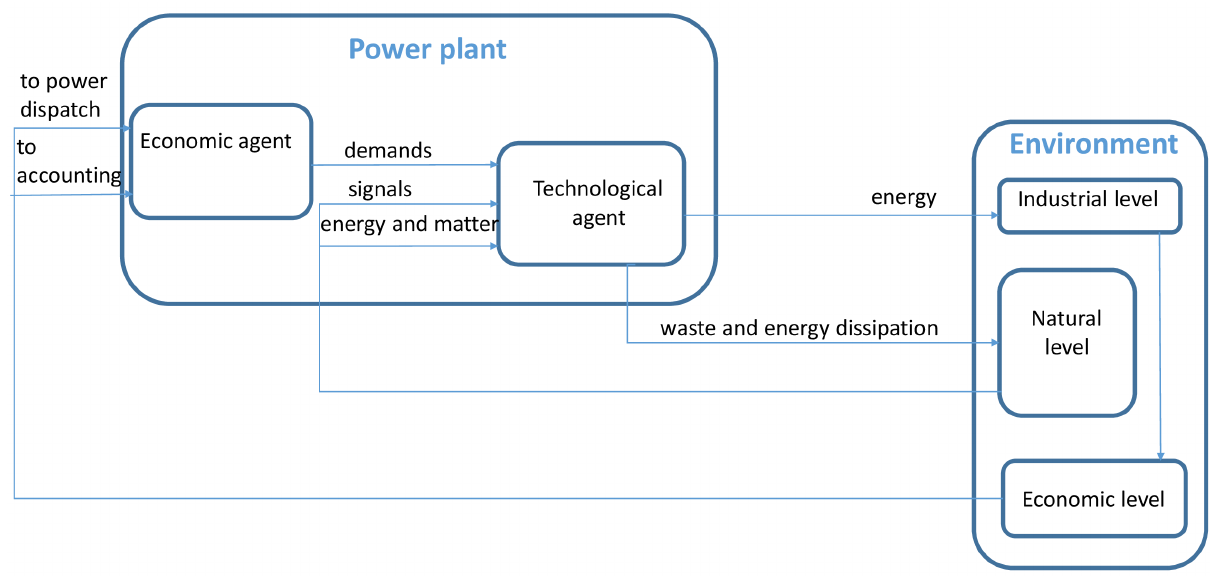
Figure 2. The organization of the thermal power plant and its relationship with the